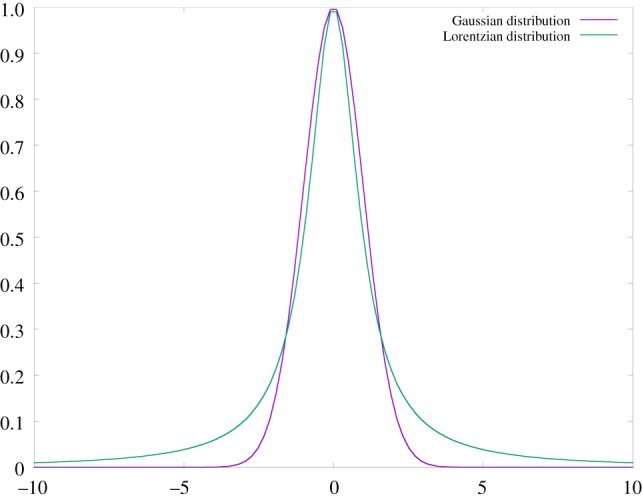
A comparison of Gaussian and Lorentzian distributions. Note the persistence in the latter distribution of far larger events from the mean. To emphasize the different decay away from the peak (most probable) value, such peak is taken to be the same for both distributions, which means that they are not normalized to the same value. (Online version in colour.)